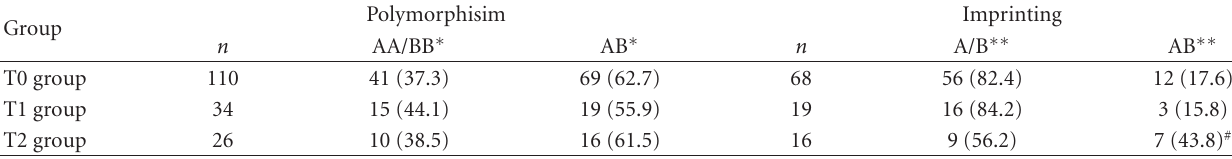
Table 3: Polymorphisms and imprinting of the IGF-II gene in placenta [n (%)].